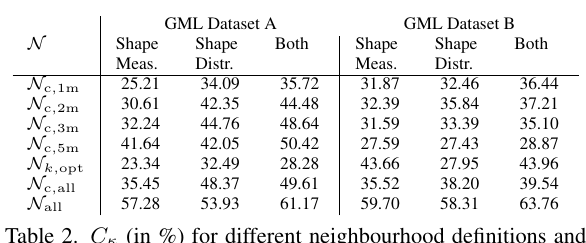
Figure 2. Visualisation of the five shape distribution metrics A3, D1, D2, D3 and D4.